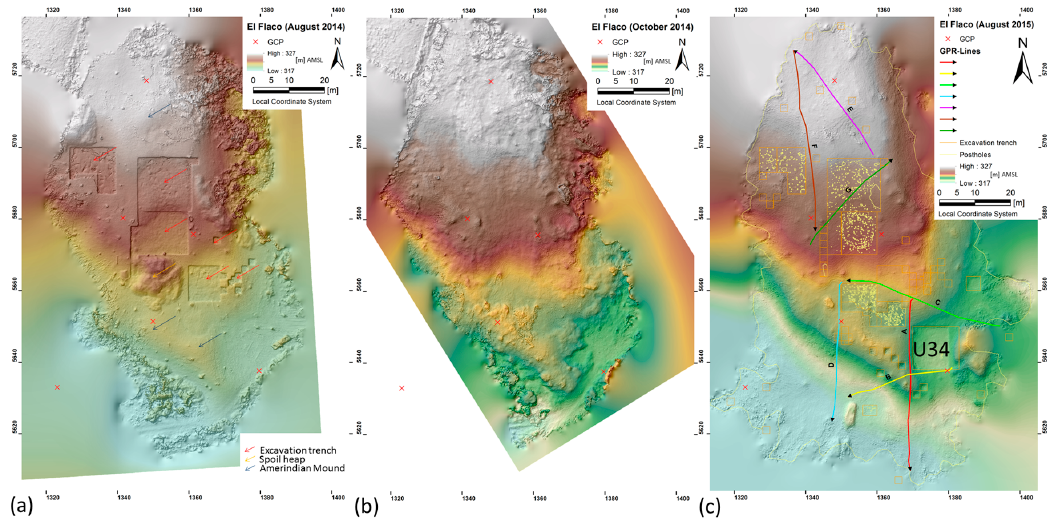
Figure 4. Changes of the topography over time, visualized as a digital elevation model (DEM) overlaying a hill shade model, created from drone imagery at the Amerindian settlement site of El Flaco from ( a ) August and ( b ) October 2014, as well as ( c ) August 2015, with the transects of the GPR (ground penetrating radar) survey.